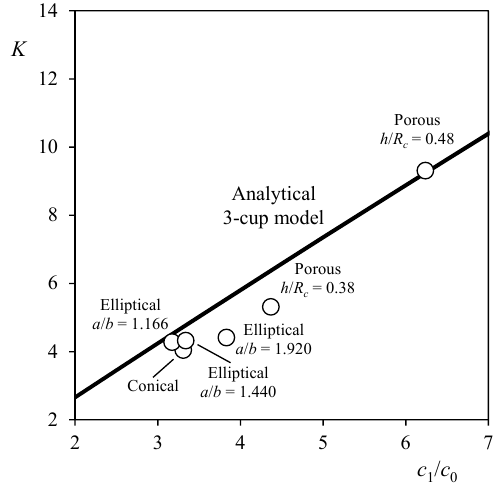
Figure 10. Results of the developed analytical model (Equation (15)), compared to testing results. In the graph, the anemometer factors, K , measured and calculated from anemometers equipped with the same rotor varying only the aerodynamic characteristics of the cups, are plotted as a function of those aerodynamic characteristics c 0 / c 1 (see Equation (12)).